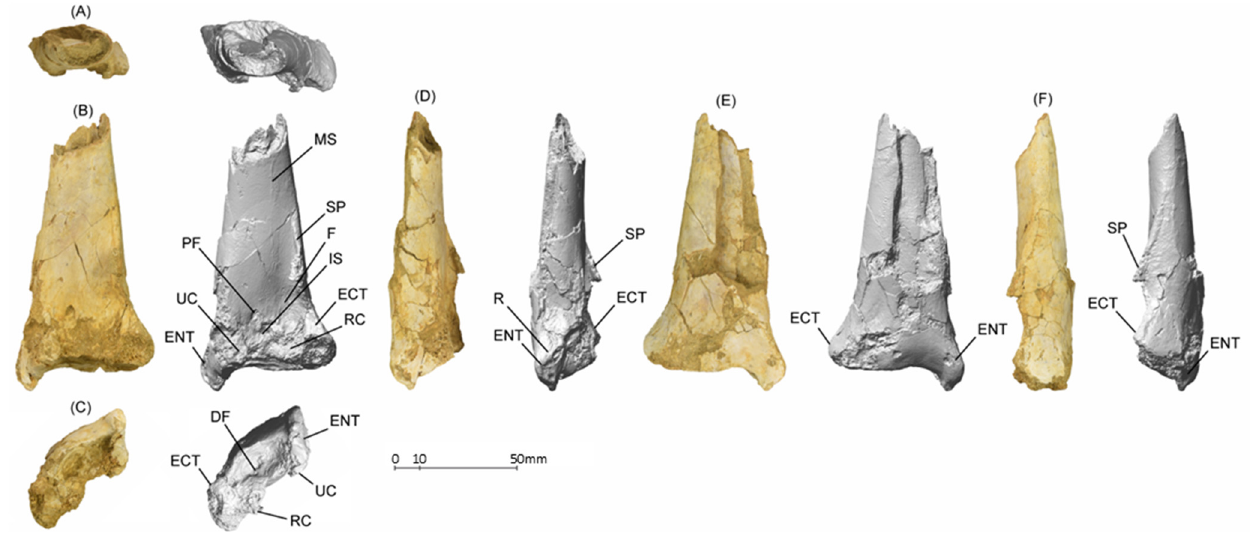
Figure 3. Holotype MGUAN-PA650 Epapatelo otyikokolo , gen. et sp. Nov. left humerus fragment. Photographs and surface scans in ( A ) proximal, ( B ) anterior, ( C ) distal, ( D ) ventral, ( E ) posterior, and ( F ) dorsal views. Abbreviations: DF, distal fossa; ECT, ectepicondyle; ENT, entepicondyle; F, fossa; IS, intercondylar sulcus; MS, muscle scar; PF, pneumatic foramen; R, ridge; RC, radial condyle SP, supracondylar process; UC, ulnar condyle.